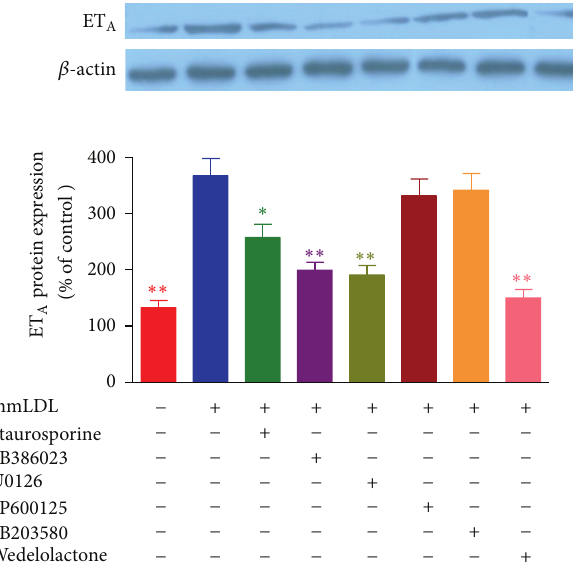
Figure6:EffectofmmLDLandtheintracellularsignalinginhibitors on the level of expression of ET A receptor protein in the coro- nary artery. Rat coronary arteries were cultured with mmLDL (10 𝜇 g/mL) in the presence of the PKC inhibitor staurosporine, ERK1/2 inhibitors SB386023 and U0126, JNK inhibitor SP600125, p38 inhibitor SB203580, and NF- 𝜅 B inhibitor wedelolactone for 24 h. The levels of ET A receptor protein were determined by western blotting. The results are expressed as the mean ± SEM. 𝑛 = 3 - 4 (each sample being a pool of 4 coronary arteries). ∗ 𝑃 < 0.05 , ∗∗ 𝑃 < 0.01 versus